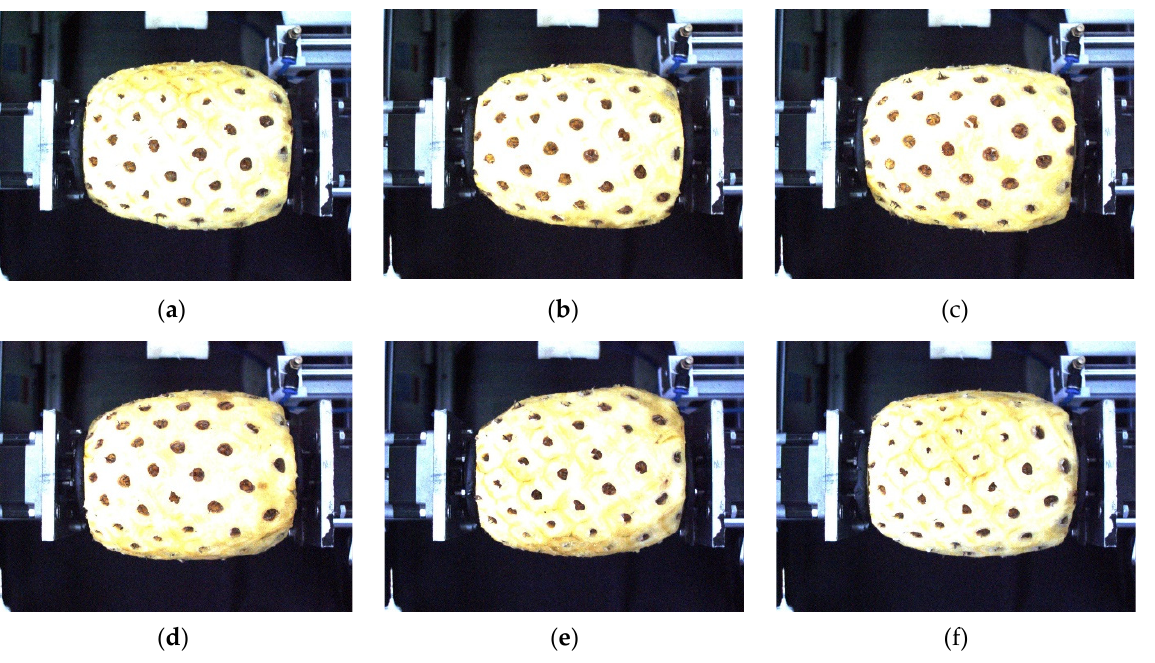
Figure 2. Images of the same pineapple at different angles. ( a ) 0 degrees; ( b ) 60 degrees; ( c ) 120 degrees; ( d ) 180 degrees; ( e ) 240 degrees; ( f ) 300 degrees.